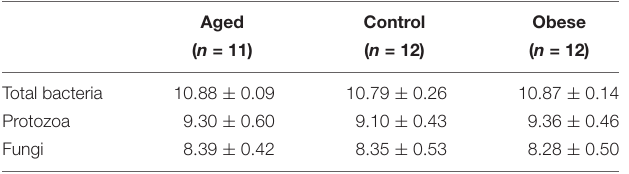
TABLE 3 | Copy numbers for total bacteria, protozoa and fungi in the feces of the 3 phenotypic groups. Aged Control Obese